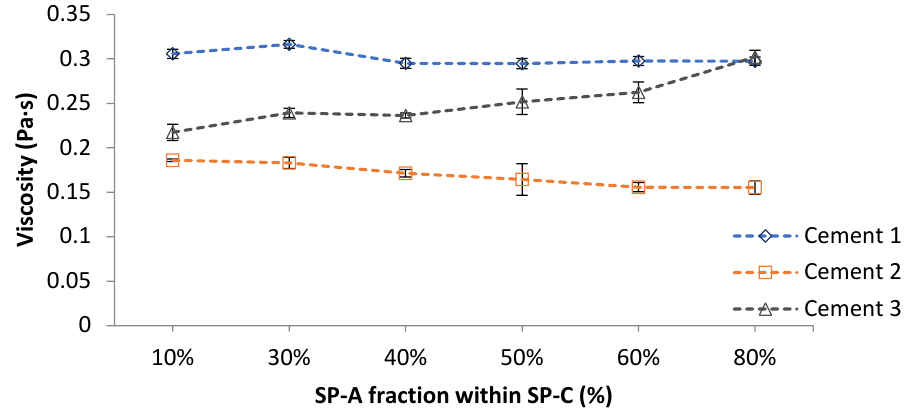
Figure 5. Summary of the plastic viscosity (Pa · s) of Cement 1, Cement 2 and Cement 3 with the addition of SP-C at 0.25% .